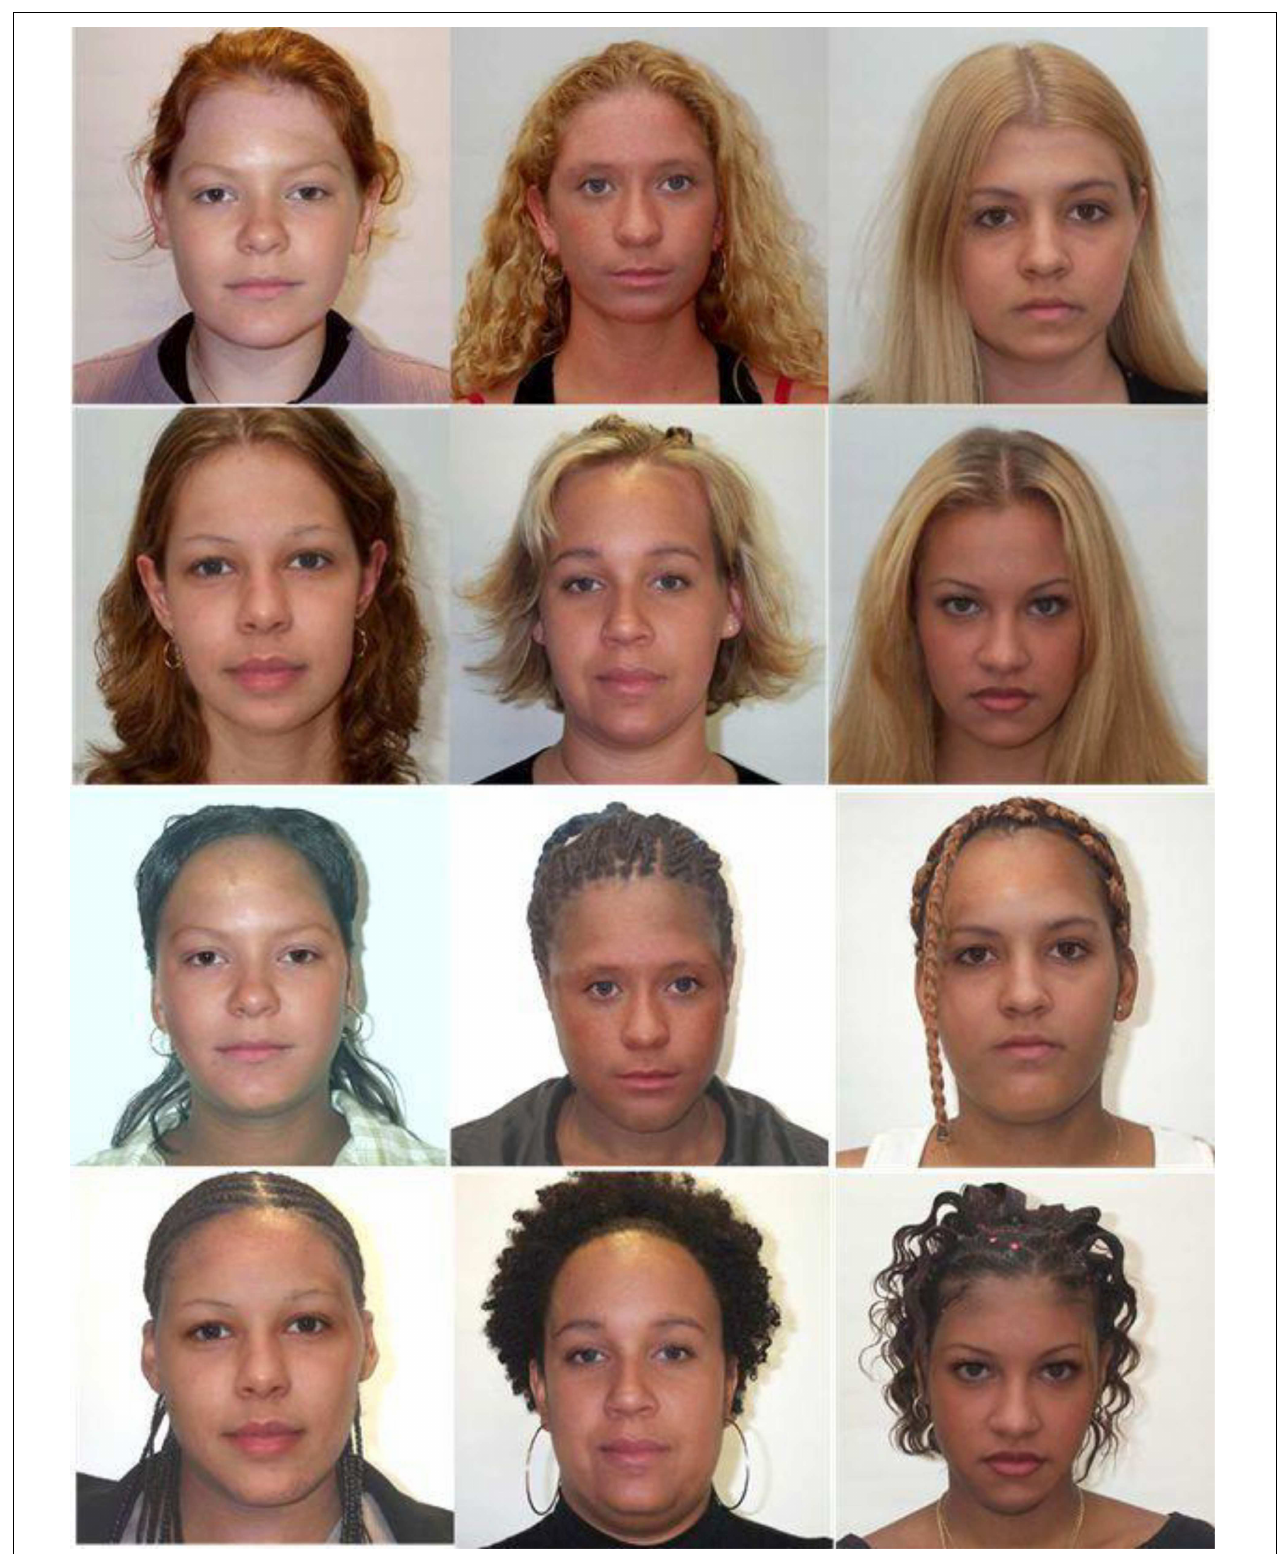
FIGURE 2 | The six pairs of race-interchangeable faces. Pairs have identical internal features but different external features leading to a perception of different races between the pairs.